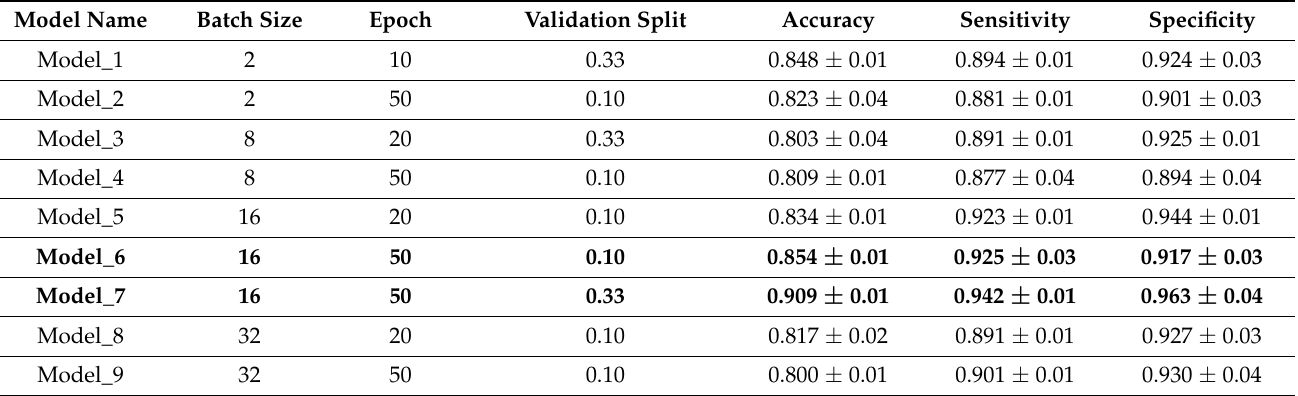
Table 1. Performance of the U-Net model for the test sets.